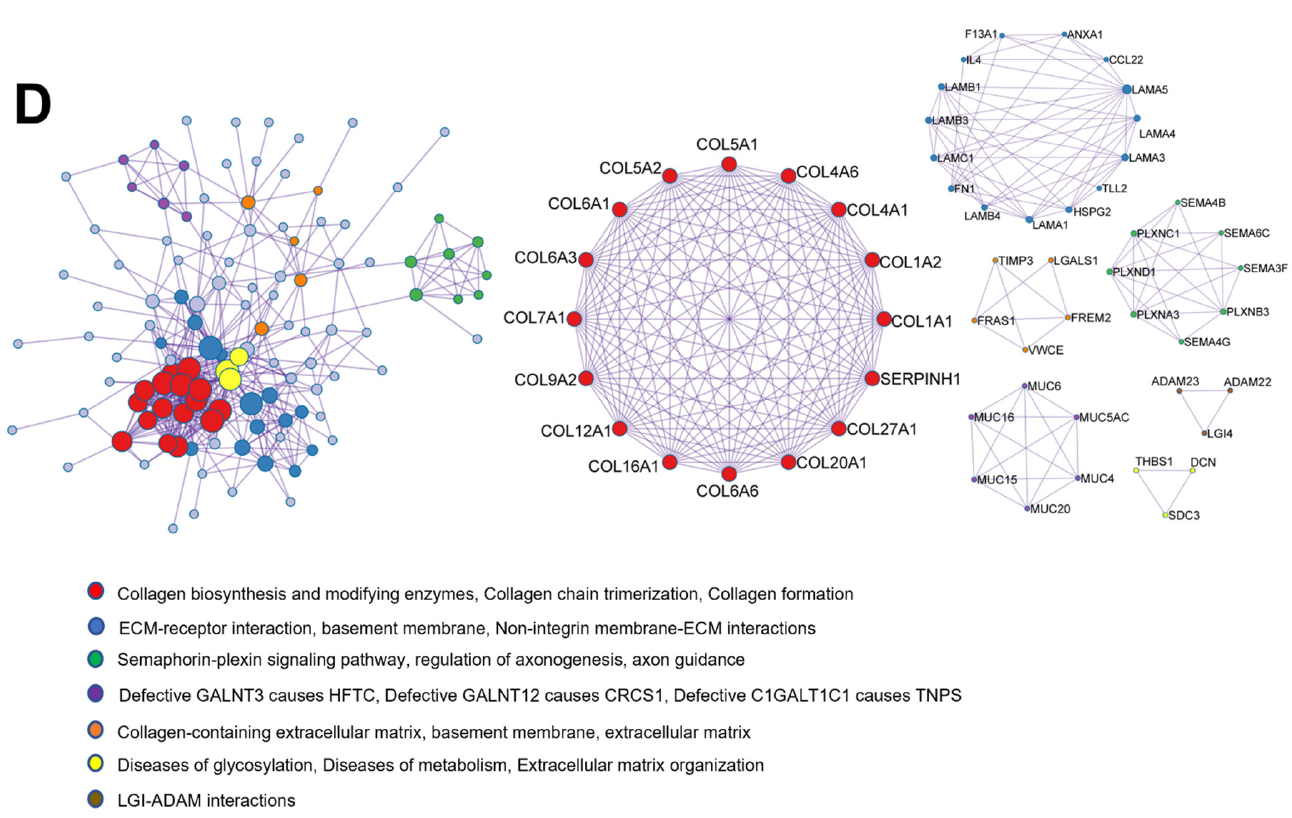
Figure 7. Schematic exhibited protein–protein interaction network and the Molecular Complex Detection (MCODE) components identified in the common matrisome gene lists of ( A ) cytosol, ( B ) membrane, ( C ) nucleus, and ( D ) cytoskeleton compartment, respectively. The analyses were performed using Metascape [32], and enrichment networks were generated using Cytoscape version 3.9.1 [33].